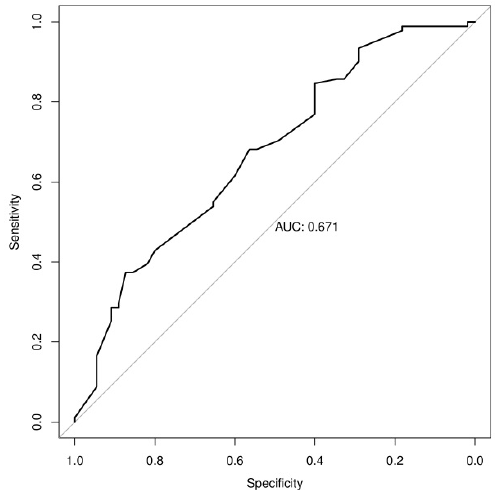
Figure 1. Receiver Operating Characteristic analysis and the related Area Under the Curve for nod- ule